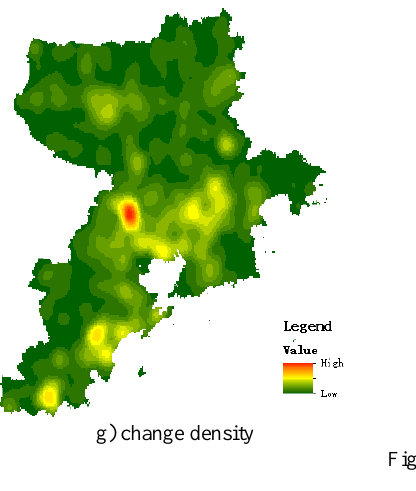
Figure 4. LST-Change density